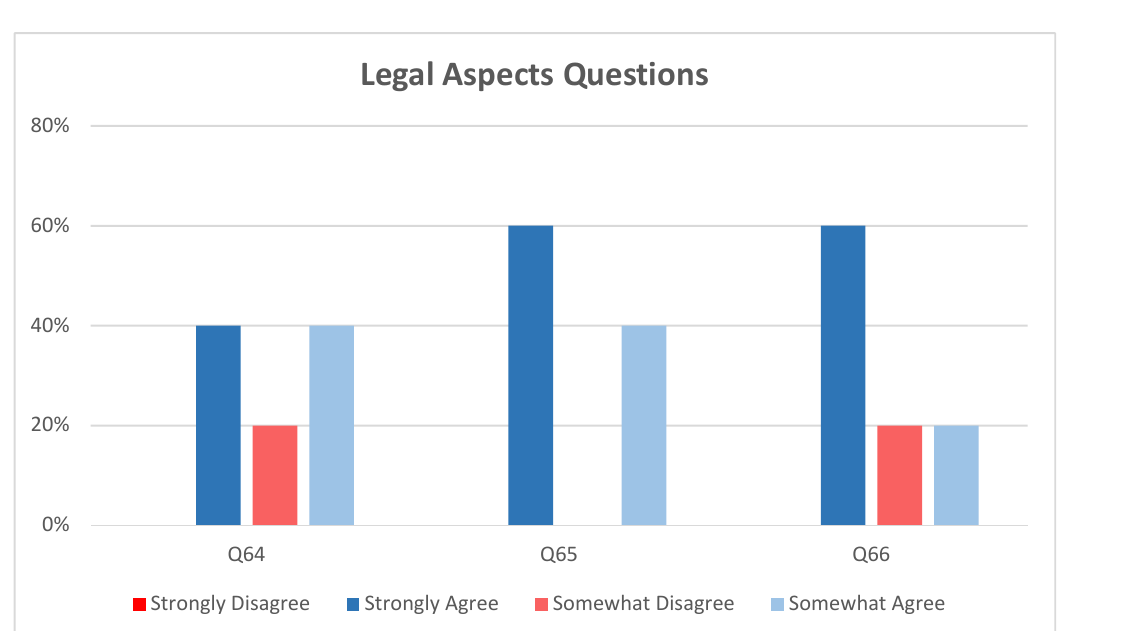
Figure 17. Results for the questions on legal aspects .